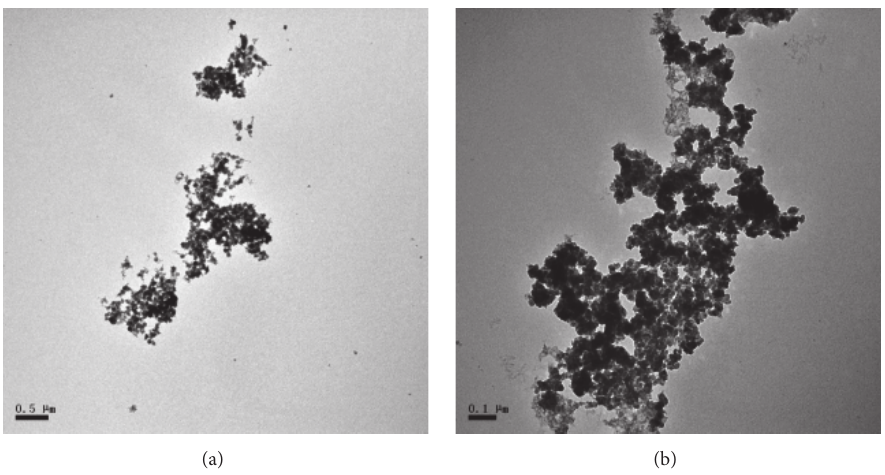
Figure 2: TEM of Fe 3 O 4 nanoparticles (a) and Fe 3 O 4 @MIPs particles (b).